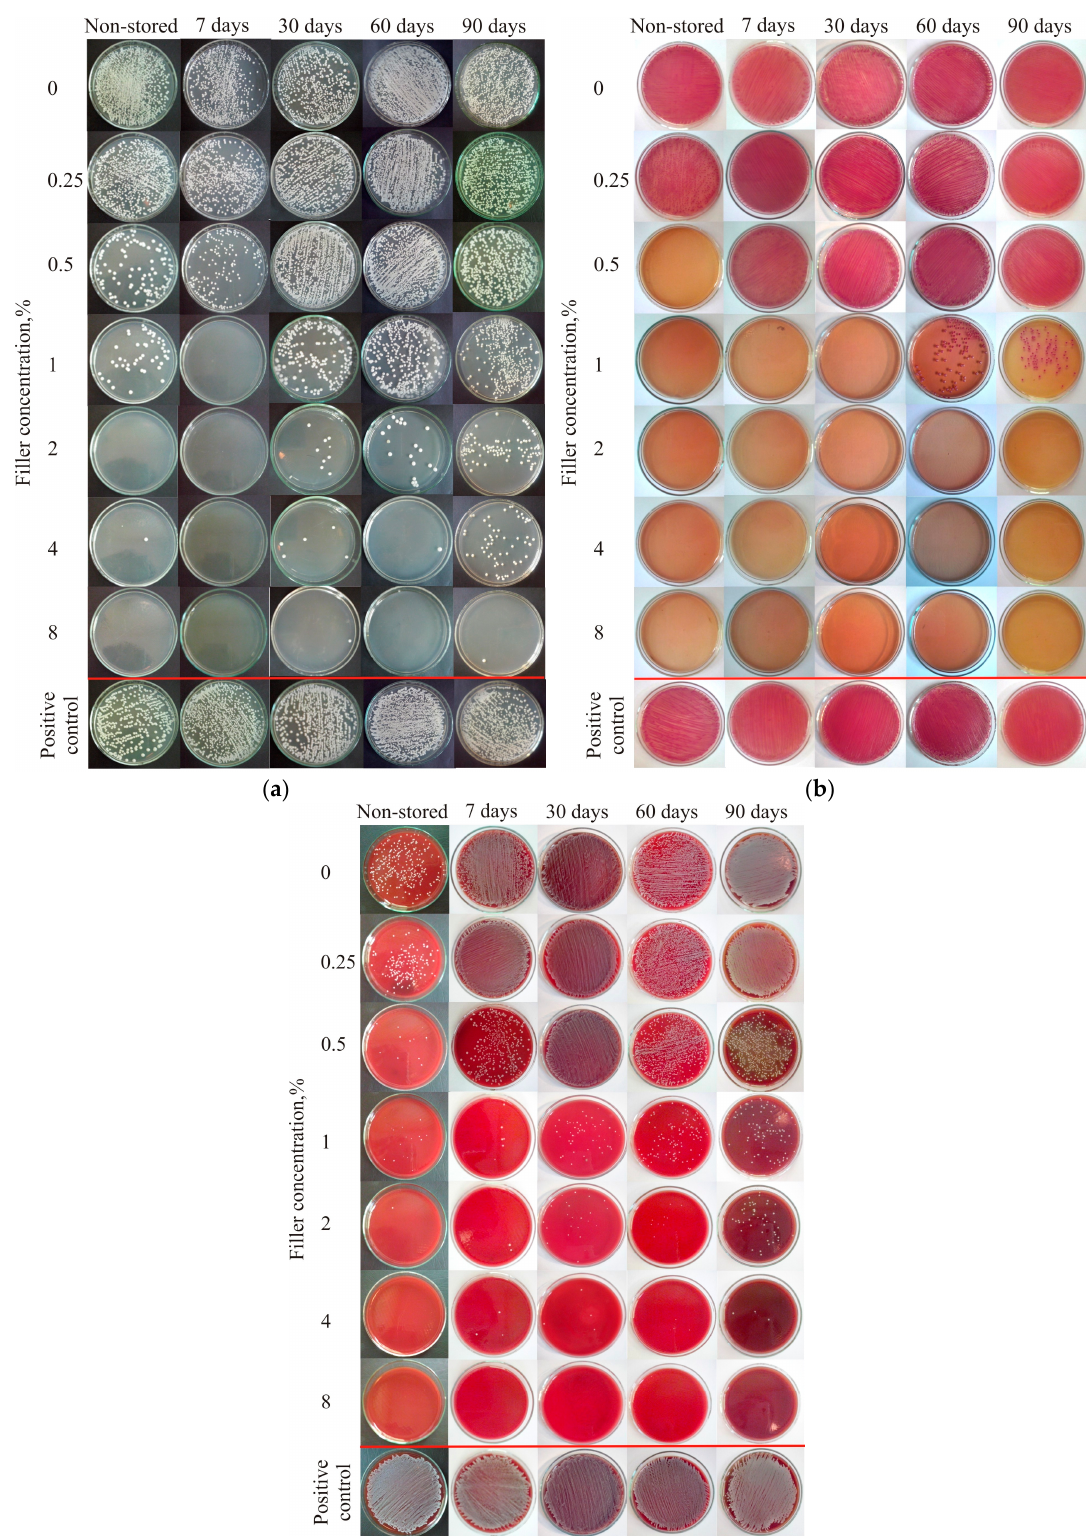
Figure 4. Representative results of the antifungal tests against ( a ) Candida albicans ATCC 10231; ( b ) Escherichia coli ATCC 25922; and ( c ) Staphylococcus aureus ATCC 25923 after 17 h of incubation with samples of the PMMA resin and composites previously stored in distilled water.